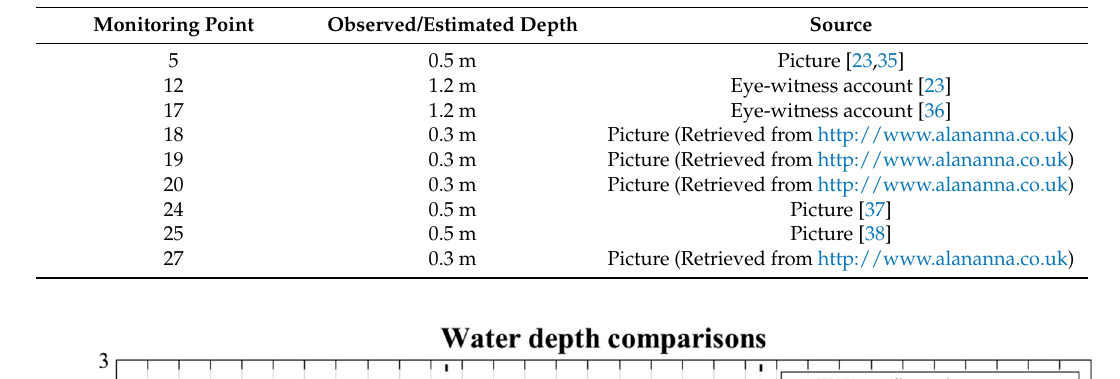
Table 2. The observed/estimated flood levels for the 2012 River Leri flash flood.